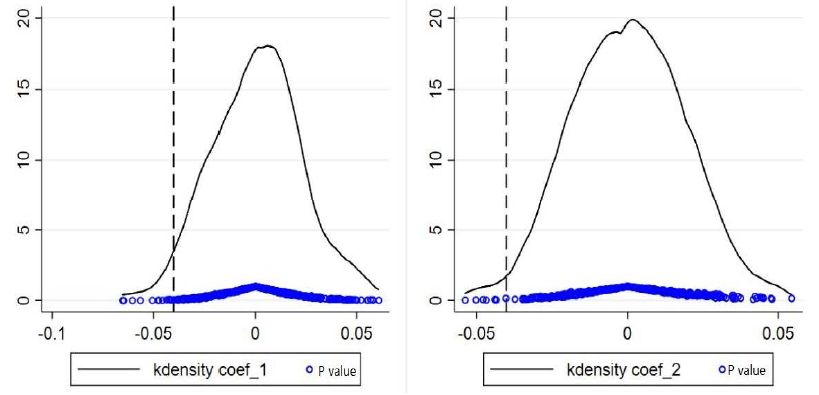
Figure 8. Placebo